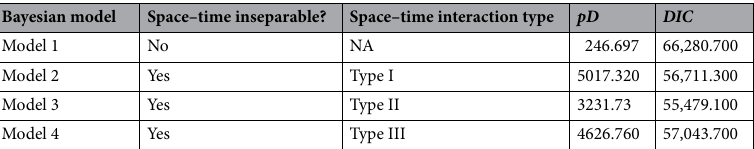
Table 3. Comparison of the four space–time models.